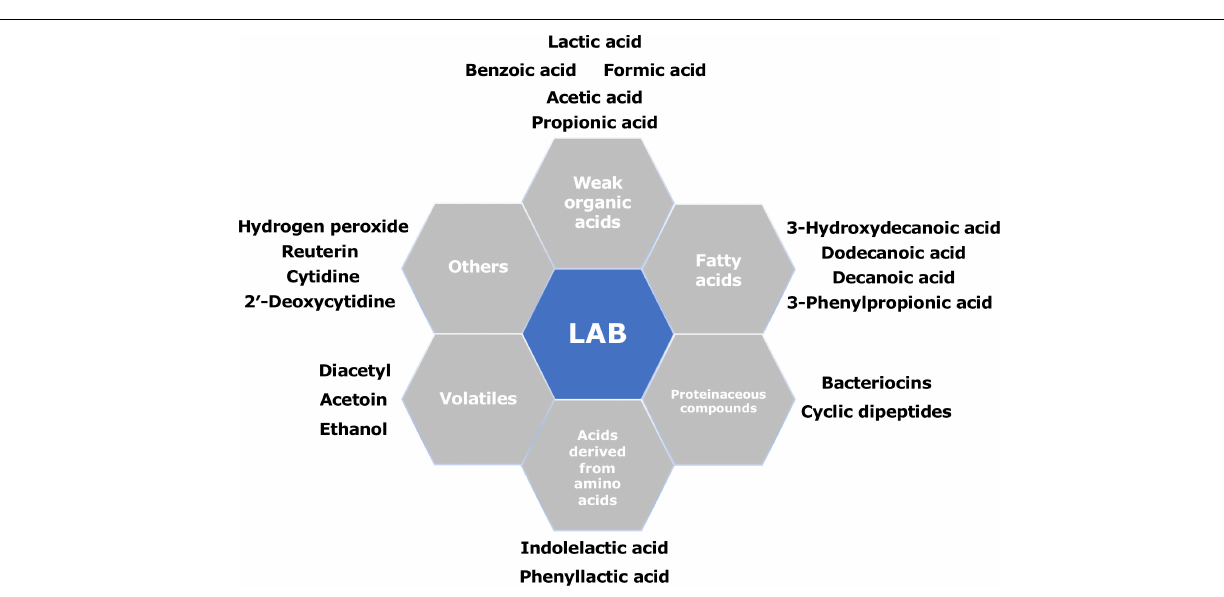
FIGURE 2 | Summary of the main antifungal compounds produced by different lactic acid bacteria